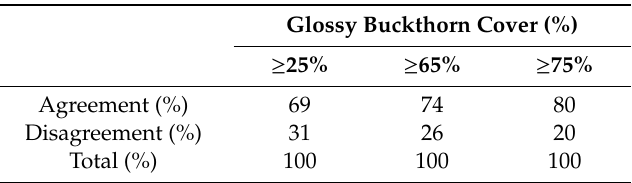
Table 4. Agreement and disagreement values calculated from the confusion matrices of di ff erent glossy buckthorn cover classes. Each confusion matrix used the same amount of absence plots (N = 10) but decreasing numbers of presence plots ( ≥ 25%: N = 90 (lowest glossy buckthorn cover), ≥ 65%: N = 60 (average glossy buckthorn cover), ≥ 75%: N =